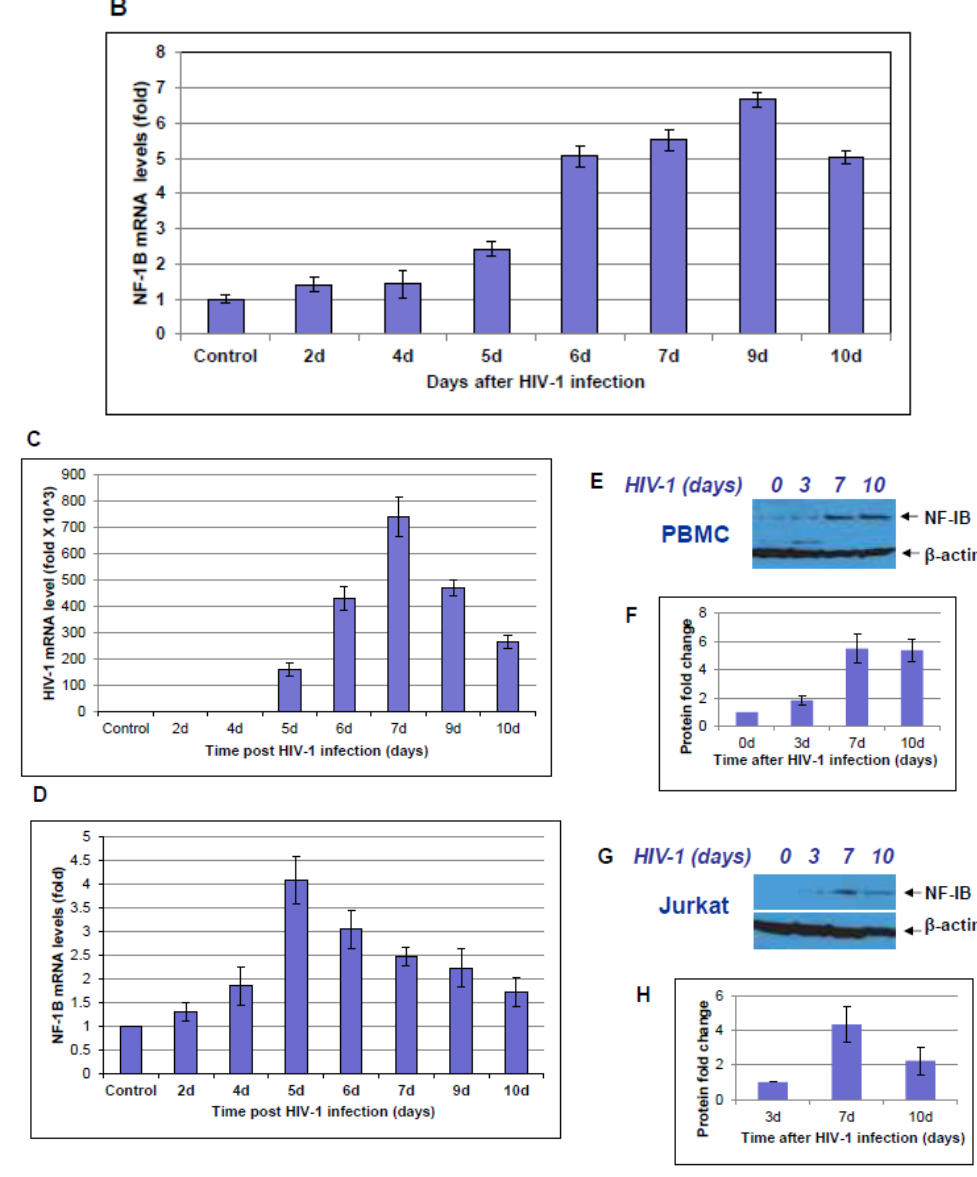
Figure 1. HIV-1 RNA expression level following HIV-1 infection. Peripheral blood mononuclear cells (PBMCs) from three different donors ( C ), and Jurkat cells ( A ) were infected with HIV-1 (III-B strain; 5 ng equivalent of p24/10 6 cells). At the indicated time points post-infection, 1 × 10 6 cells were used to measure HIV-1 gag gene expression levels using real-time quantitative RT-PCR. NF-IB gene expression levels were also measured from the same PBMCs ( D ), and Jurkat cell samples ( B ). The data were normalized to glyceraldehyde-3-phosphate dehydrogenase (GAPDH levels) levels and represent the mean ± standard error of the mean (SEM) from three experiments . The HIV-1 infected PBMCs ( E ) and Jurkat cells ( G ) were lyzed and the NF-IB protein level was measured using Western blot. Beta-actin was used as an internal control. Quantification of signals from Western blots was done using Image J software (1F; PBMCs and 1H; jurkat cells). Fold change is relative to 0 d time point. Data are averages of Western blot quantifications ± SEM. Representative Western blots are